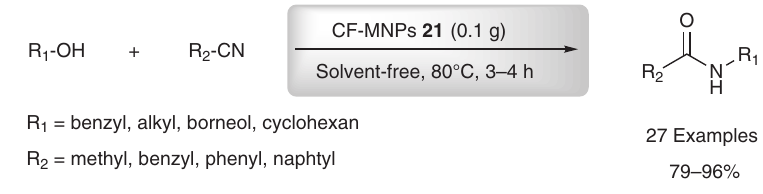
Scheme 27: CF-MNPs 21 catalyzed the synthesis of amides via the Ritter